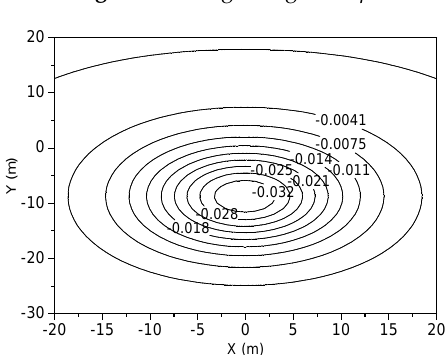
Figure 13. Integral region of p .